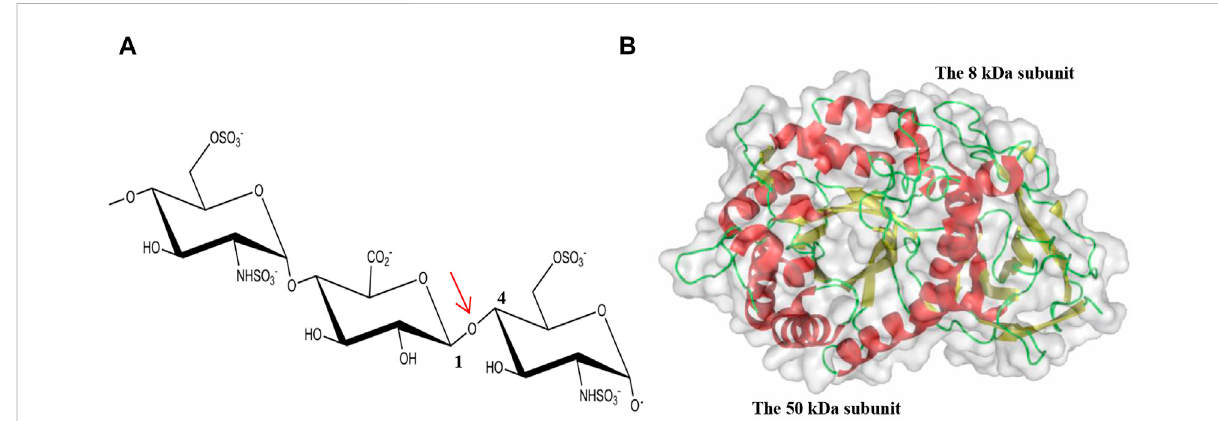
FIGURE 1 Cleavage of the glycosidic bond by HPSE. (A) The internal β (1,4)-linked glycosidic bond between GlcA and GlcNS is highlighted by an arrow in red; (B) The overall fold of hHPSE is illustrated in ribbon representation with α -helix in red, β -strand in yellow and loop in